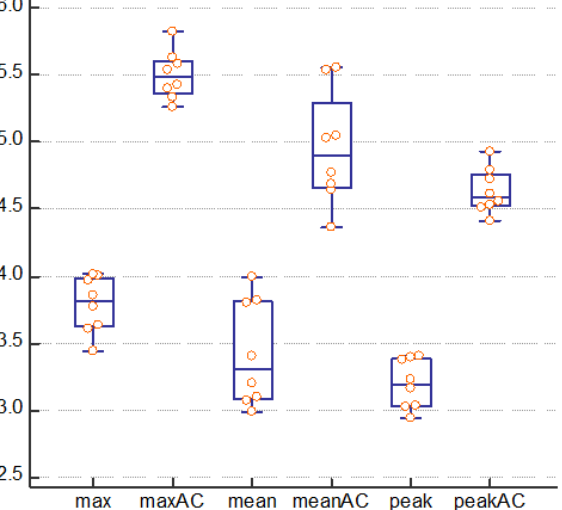
Figure 7. SUV after SPECT/CT examination with and without performing CTAC.